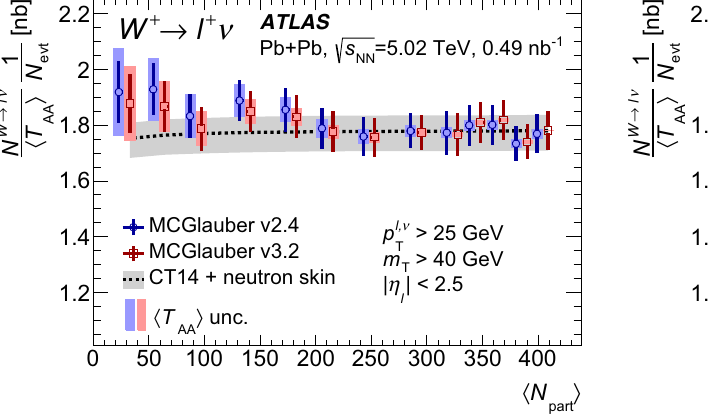
v3.2. Uncertainties related to the determination of radial distributions for nucleons are not included. Error bars show statistical and system- atic uncertainties added in quadrature, whereas systematic uncertainties due to (cid:4) T AA (cid:5) are shown as shaded boxes around the data points. The points for the MCGlauber code v3.2 are shifted horizontally for better visibility